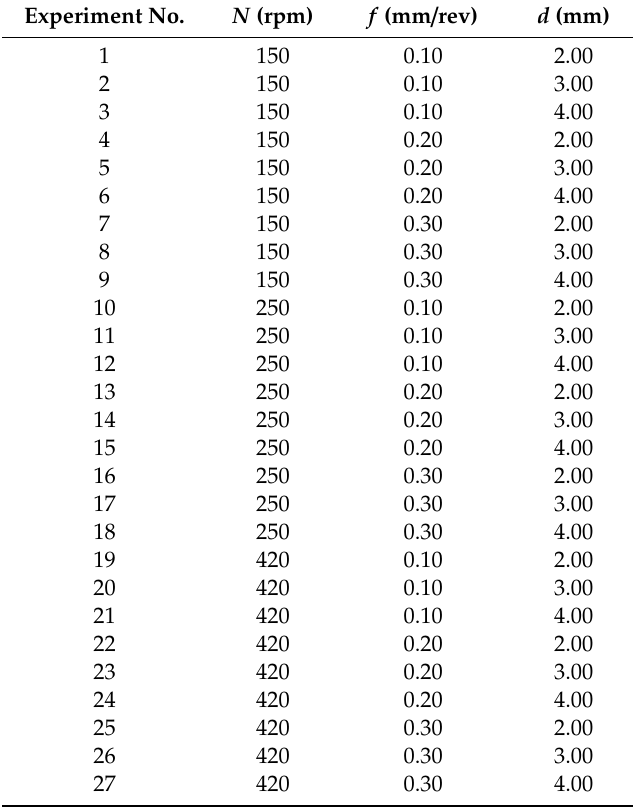
Table 4. 3 3 full factorial design of